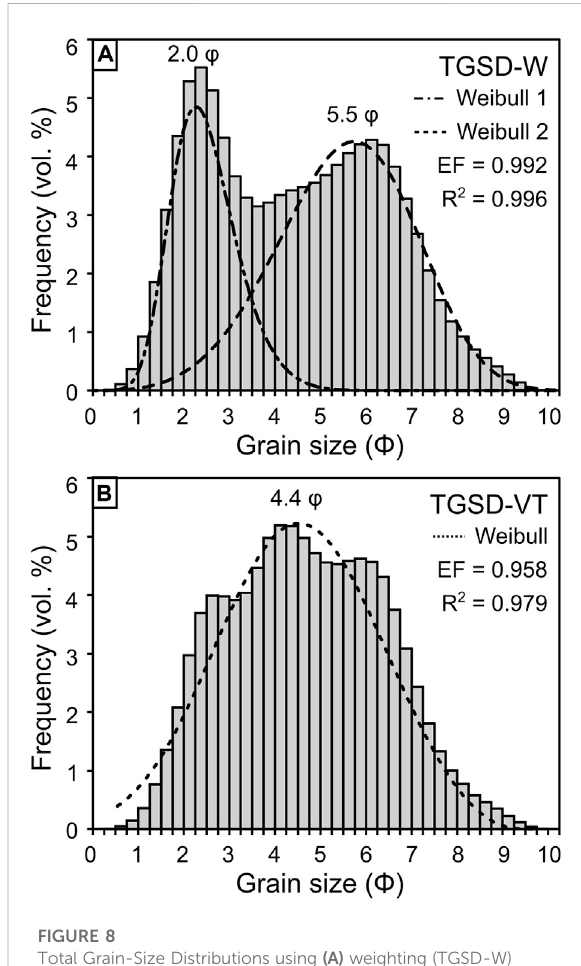
FIGURE 8 Total Grain-Size Distributions using (A) weighting (TGSD-W) and (B) Voronoi Tessellation (TGSD-VT) with Weibull sub- populations. Load is the weighting factor in the calculation of the TGSD-W. Load and Voronoi tessellas area are the weighting factor in the calculation of